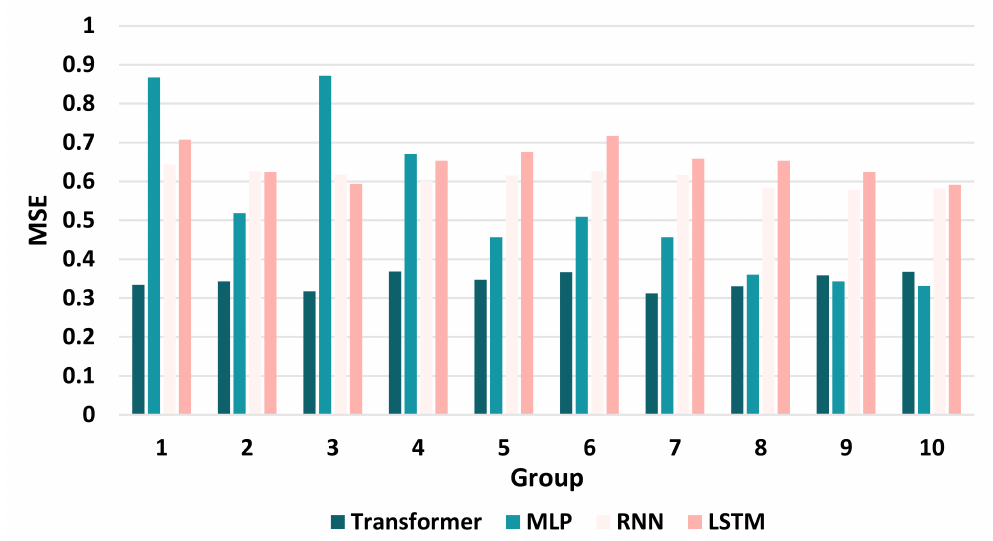
Figure 6. Changes in MSE of the model in different variable